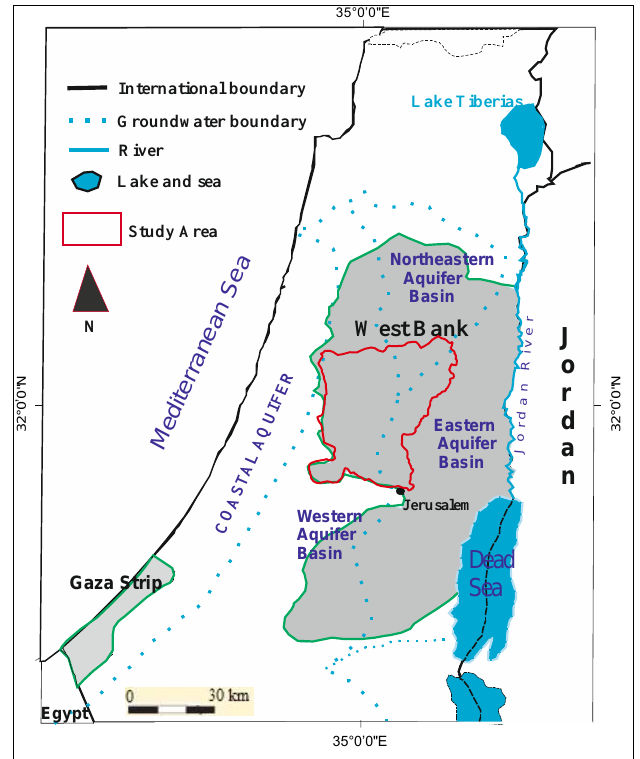
Figure 1. Location of the study area.